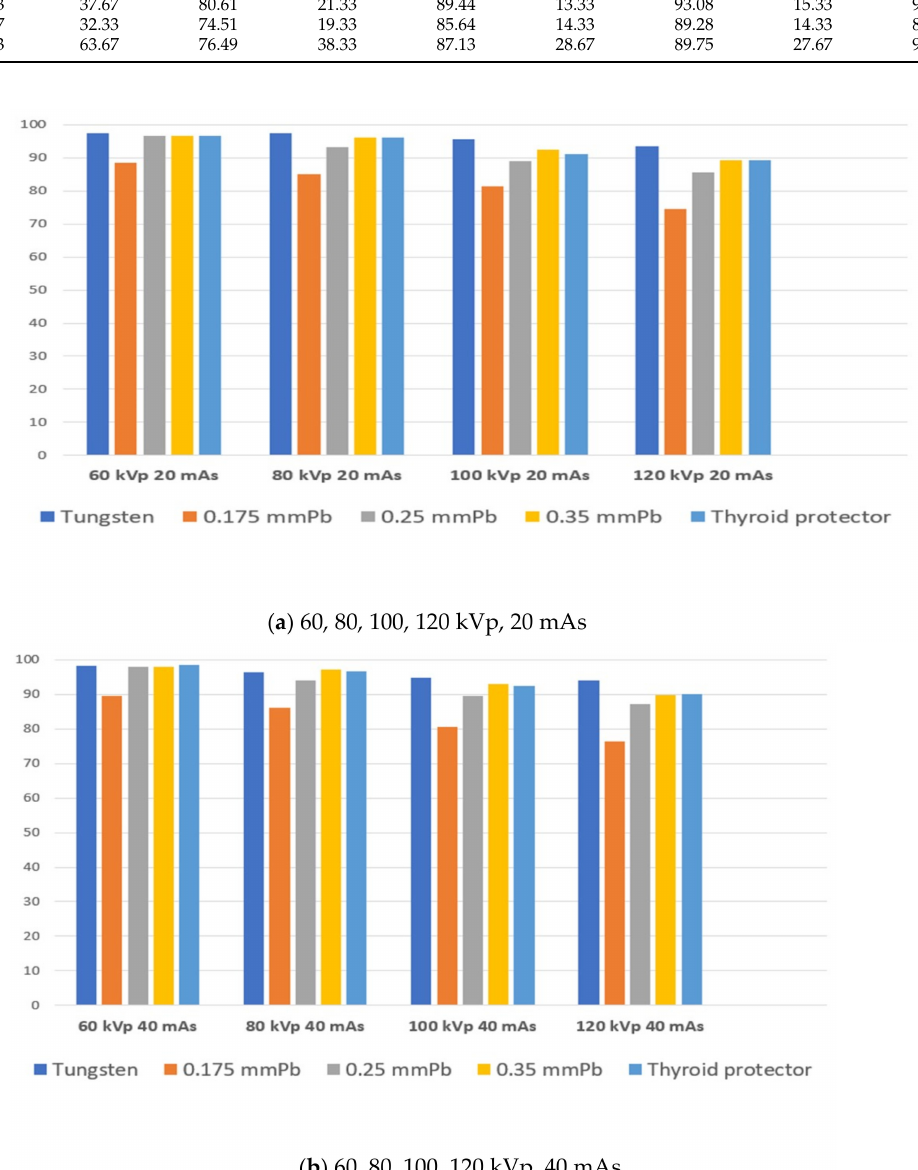
Figure 3. Comparative evaluation of the manufactured shielding sheet and lead protection tool. Based on 1 mm of the manufactured tungsten shield, ( a ) 60, 80, 100, 120 kVp 20 mAs and ( b ) 60, 80, 100, 120 kVp 40 mAs were evaluated for comparison with the existing protection